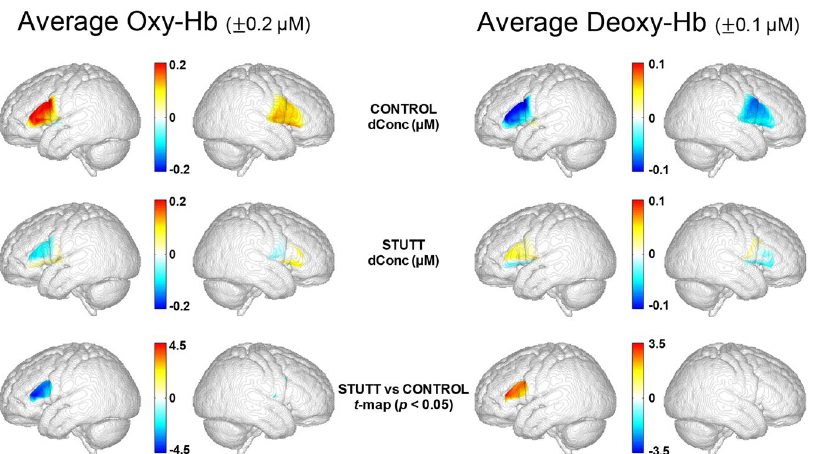
Figure 3. Topographic images of cortical activation within the boundaries of the probe derived from Oxy-Hb (left pairs) and Deoxy-Hb (right pairs) response amplitudes within the 3–8 s post-stimulus analysis window of analysis. First rows: left and right hemisphere average hemoglobin responses for the control participants. Second rows: left and right hemisphere average hemoglobin responses for group of children who stutter. Third row: t -maps outlining regions of significant difference between the control and stuttering groups (independent sample t -tests, p < 0.05, FDR-corrected). The brain templates, courtesy of John Richards’s Lab, represent average whole-head MRI images from 72 10-year-old